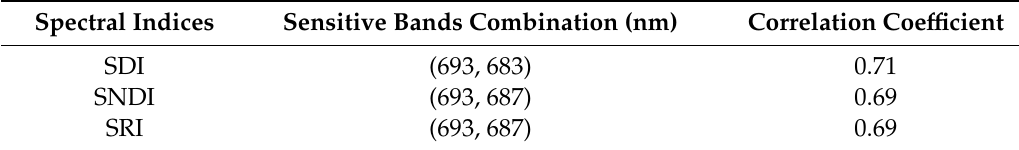
Figure 4. Search for the hyperspectral sensitive band under the spectral index. Table 4. Sensitive band selection and correlation coe ffi cients based on the spectral